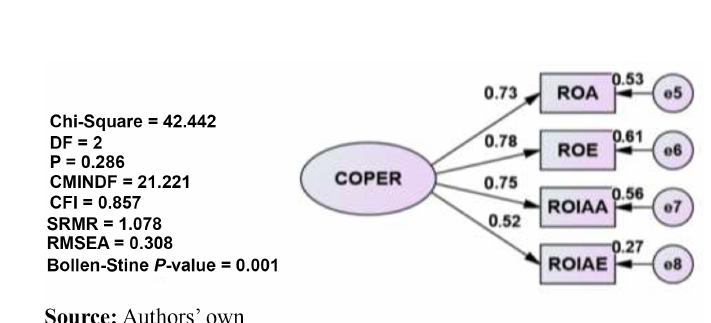
Table 7. Construct reliability and average variance extracted